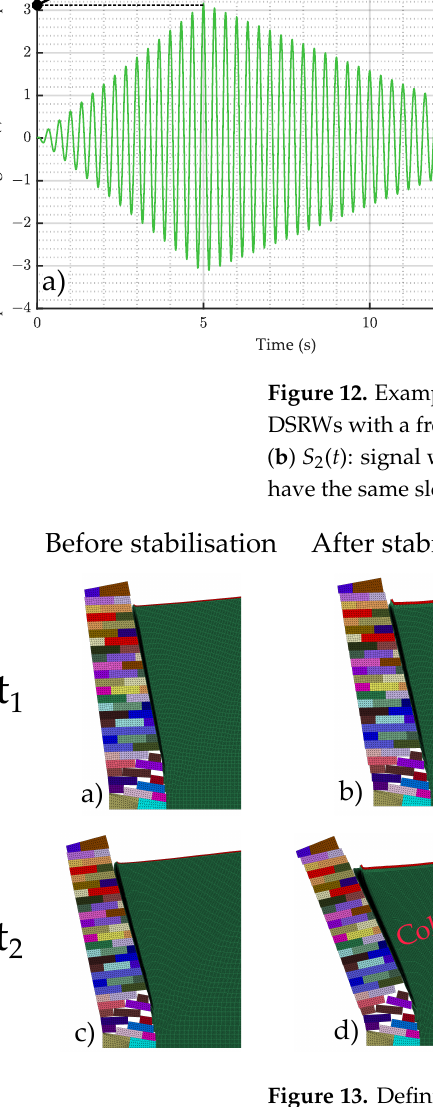
Figure 13. Definition of the threshold indicating the DSRW’s collapse using the input signal S 2 ( t ). ( a ) DSRW1 at simulation time t 1 ; ( b ) DSRW1’s stabilisation under vertical gravity only, starting from simulation time t 1 ; ( c ) DSRW1 at simulation time t 2 ; ( d ) DSRW1’s stabilisation under vertical